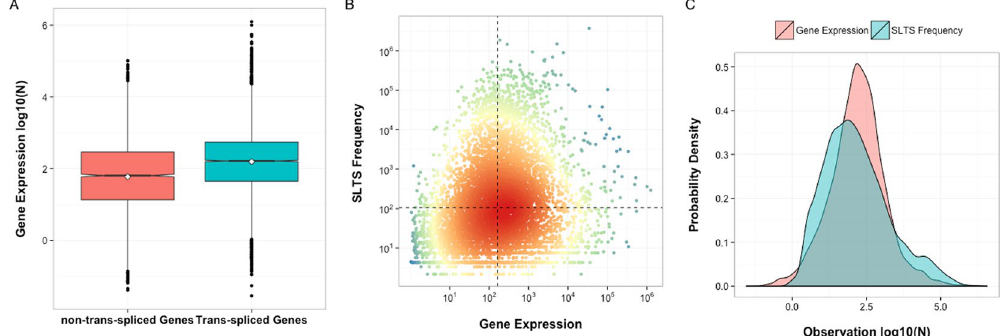
Figure 3. Relationship between gene expression and trans-splicing frequency. ( A ) Normalized log-expression levels of non-trans-spliced genes (pink box) compared with the log-expression levels of trans-spliced genes (blue box), p-value < 1.3e-08, two-sample t-test. ( B ) Normalized expression for the trans-spliced genes is compared with the normalized SLTS frequency. Dashed black lines denote the average levels of both indicators (163 for gene expression and 106 for SLTS frequency), segregating the genes with relatively low SLTS frequency (lower-right quadrant) from genes with relatively high SLTS frequency (upper-left quadrant) and comparing their expression levels (rank = 0.208, Spearman correlation coefficient). ( C ) The probability distribution of the gene expression levels (pink curve) and SLTS frequencies (blue curve) (p-value < 0.11,